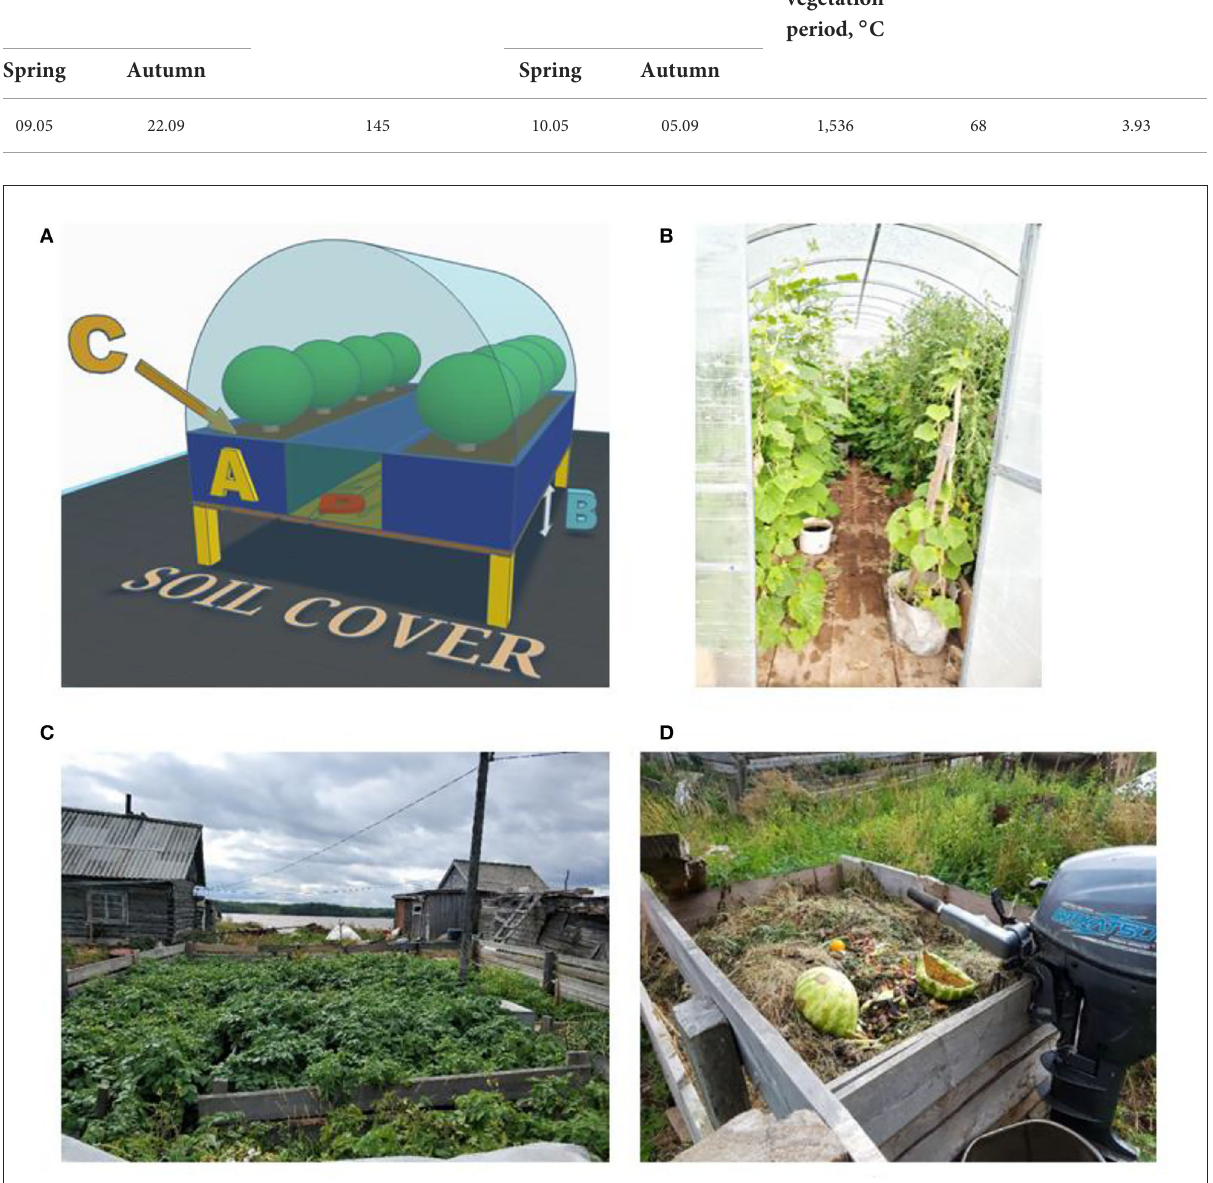
FIGURE3 Greenhouses and vegetable gardens in Tovopogol Village. (A) The layout of the greenhouse, where: A, wooden boxes; B, an air gap between the soil cover and the greenhouse floor (20–30cm); C, organic compost; and D, wooden floor (sometimes it is additionally insulated with a layer of polystyrene). (B,C) Photographs of the greenhouse and vegetable garden. (D) Wooden box for organic